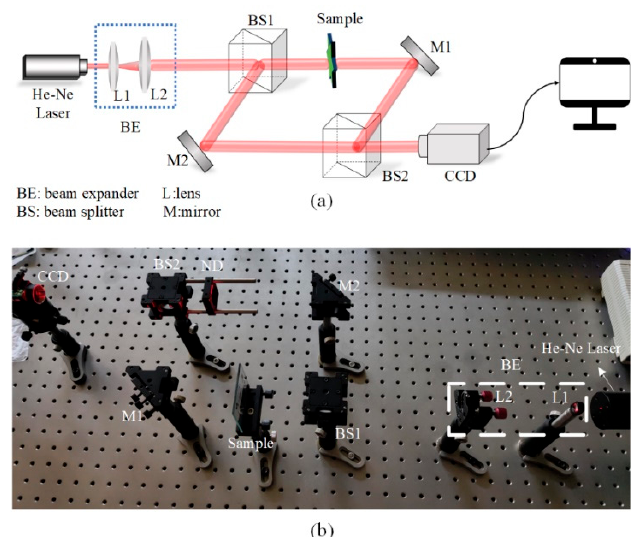
Figure 3. Schematic diagram and physical diagram of digital recording optical path based on Mach– Zender interferometer. ( a ) Schematic diagram. ( b ) Physical diagram.